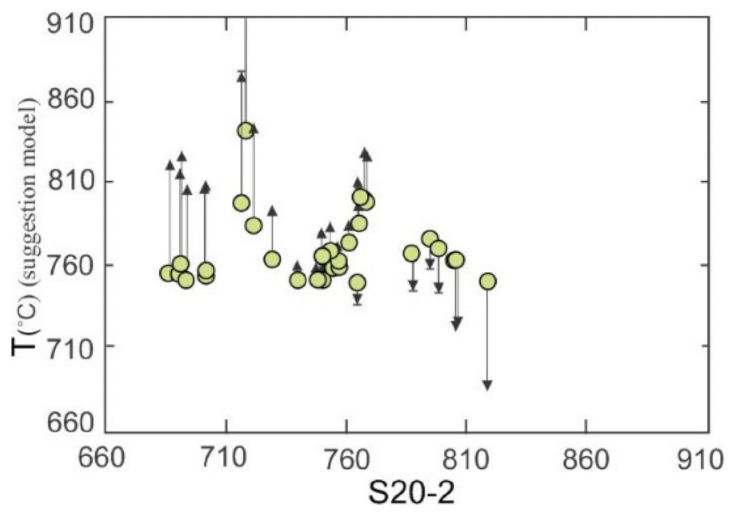
Figure 14. The assessment of estimated temperature in the suggested model for peralkaline to alkaline rocks versus estimated temperature by using S20-1. The correlation shows that HFSE- based thermometry mode could be used to estimate temperature and it is extremely close to zircon saturation temperature for peralkaline to alkaline data. The length of the arrow shows the differences in suggested temperature in here with S20-2 (n = 26 sample alkaline of Basin and Range from geochemical data http://georoc.mpch-mainz.gwdg.de/georoc/, accessed on 29 August 2021